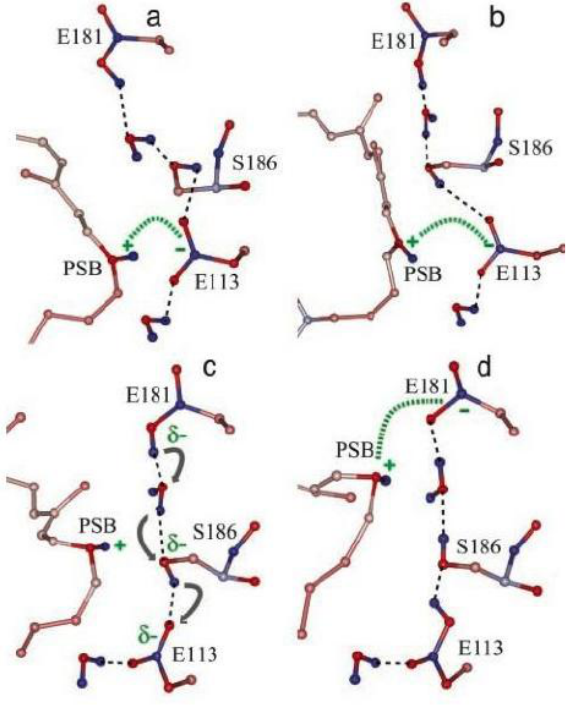
Figure 10. Counterion switch in rhodopsin photoactivation (reproduced with permission from the National Academy of Sciences